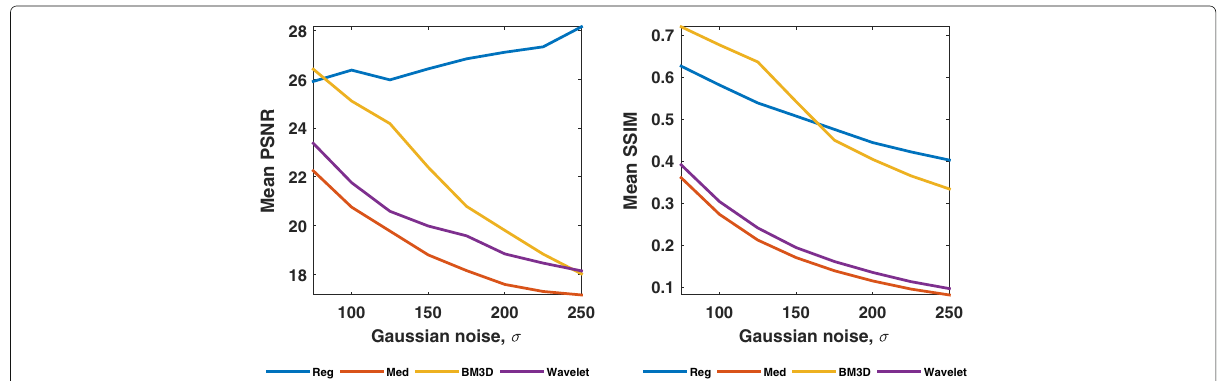
Fig. 8 Average denoised PSNR and average denoised SSIM using Median, BM3D, wavelet and regression filters for an added Gaussian noise with variance σ 2 ; averaging over six